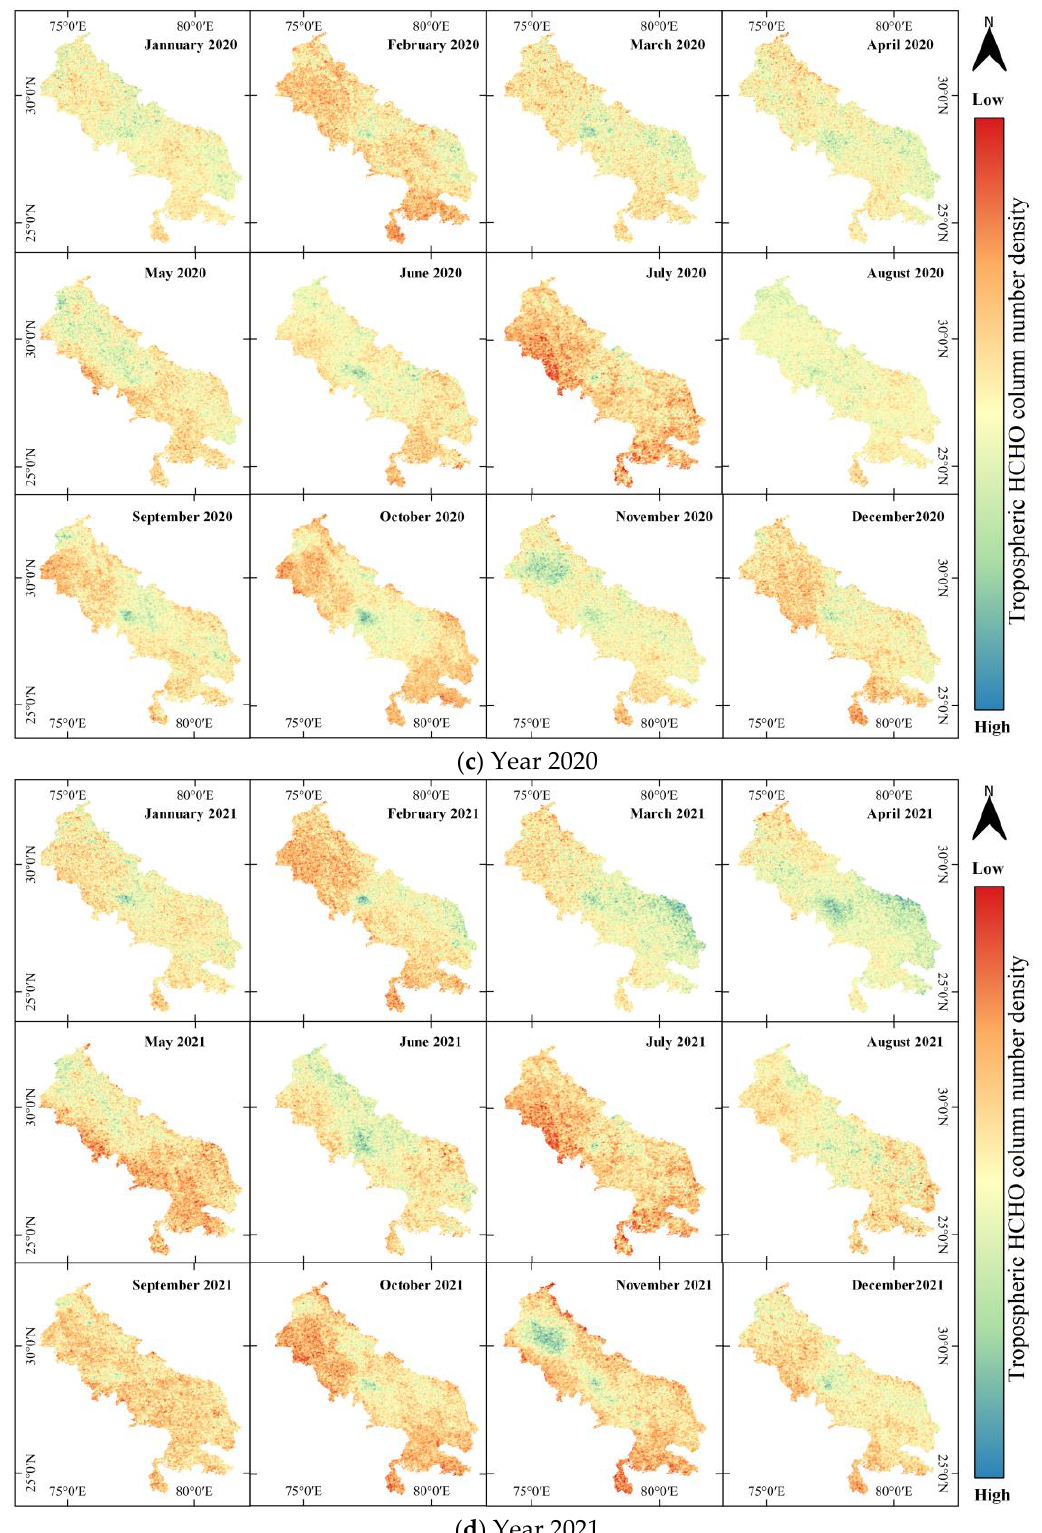
Figure 11. Atmospheric HCHO concentration over the study site (based on data availability from